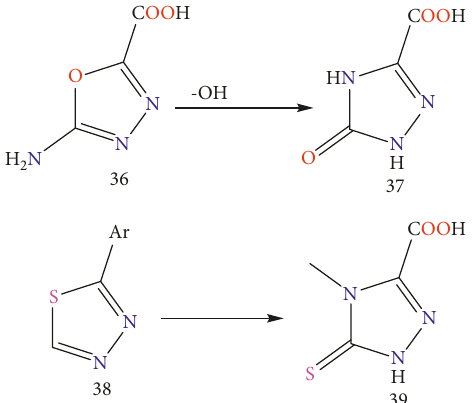
Scheme 16: Synthesis of 1,2,4-Triazole Transformation of Other Heterocyclic Systems.